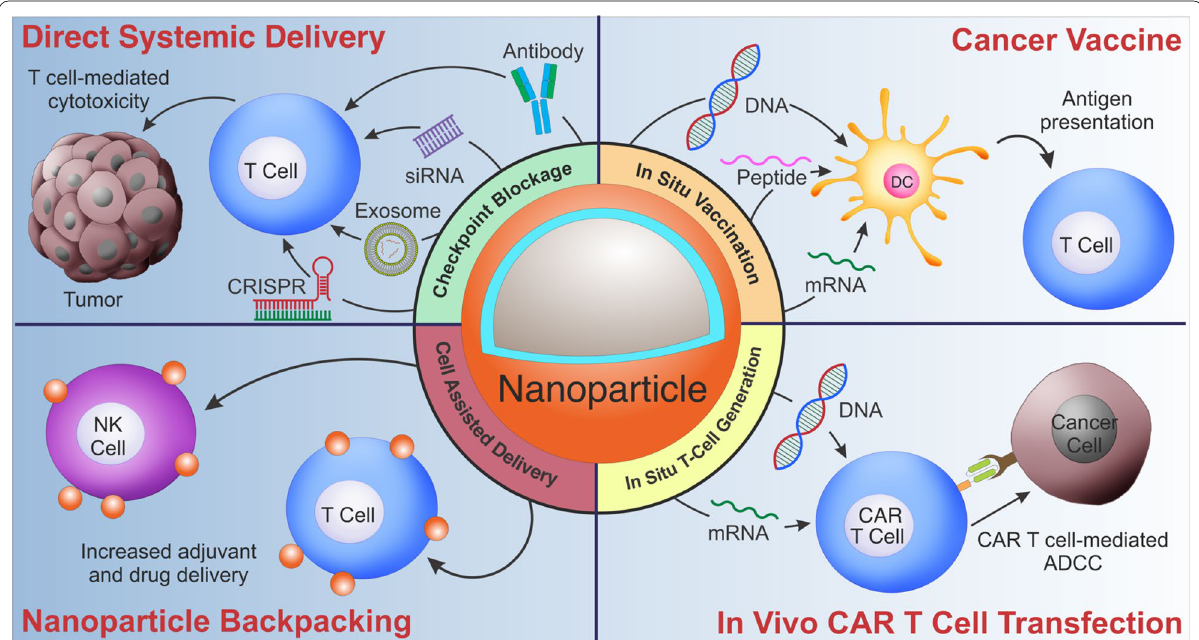
Fig. 2 Nano‑immunoengineering for cancer therapy. Nanoparticles can be utilized for various applications, including (i) delivering immunomodulatory molecules, including checkpoint inhibitors in the form of proteins or nucleic acids to enhance T cell immunity or reprogram the tumor microenvironment; (ii) generating effective cancer vaccines via transfecting DCs; (iii) attaching nanoparticles to T cells and NK cells to maximize localized delivery of adjuvant or drugs and limit systemic toxicities; iv) producing CAR T‑cells in situ by transfecting endogenous T